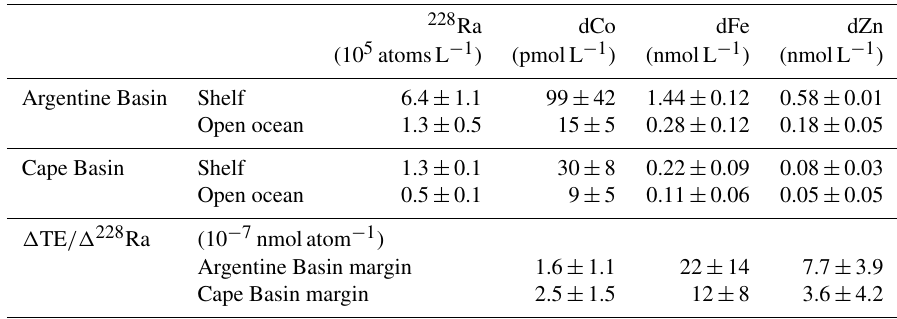
Table D1. Shelf and open-ocean average dTE and 228 Ra concentrations and (cid:49) TE /(cid:49) 228 Ra ratios ∗ .